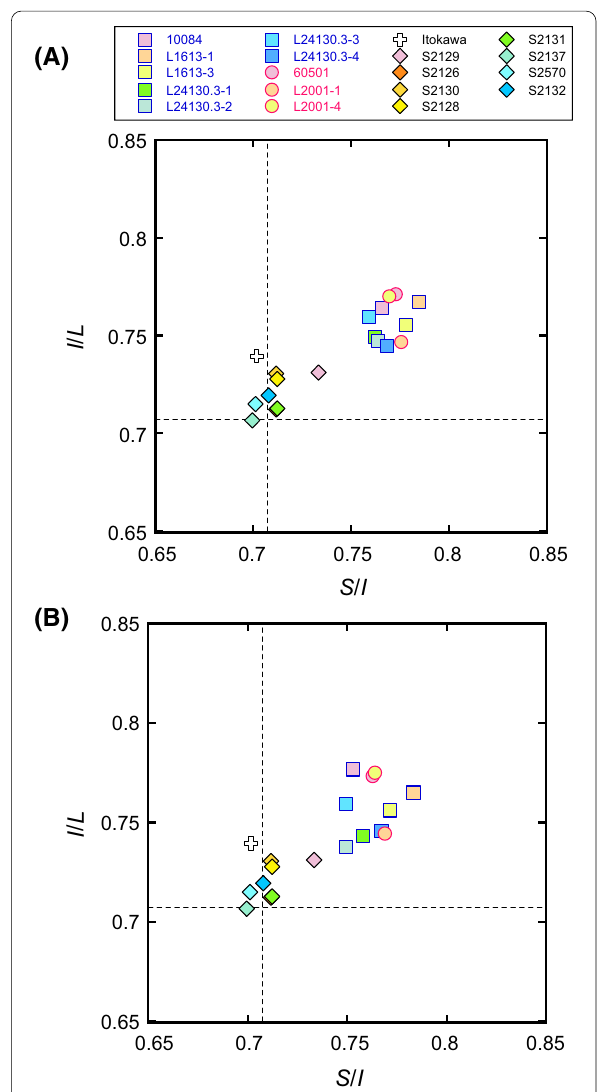
Fig. 3 Zingg diagrams showing the average tree-axial ratios of lunar regolith particles. A The average of whole texture types (m-, p-, ag-, ag/m-, and ag/p-types). B The average of only m- and p-types. The ratios of Itokawa regolith particles (Tsuchiyama et al. 2017) ( N 75) = and fragments of hypervelocity impact experiments (Michikami et al, 2018) (S2129: Q 6540 J/kg, N 117; S2126: Q 4280 J/ = = = kg, N 287; S2130: Q 2470 J/kg, N 334; S2128: Q 1190 J/kg, = = = = N 201; S2131: Q 1050 J/kg, N 295; S2137: Q 390 J/kg, N 229; = = = = = S2570: Q 270 J/kg, N 258; S2132: Q 230 J/kg, N 266) are also = = = = shown. L , I, and S are the longest, intermediate, and shortest lengths of three-axial lengths of a particle, respectively. The square and circle symbols show the samples from lunar maria and highlands, respectively. The dotted lines show the 2D silver